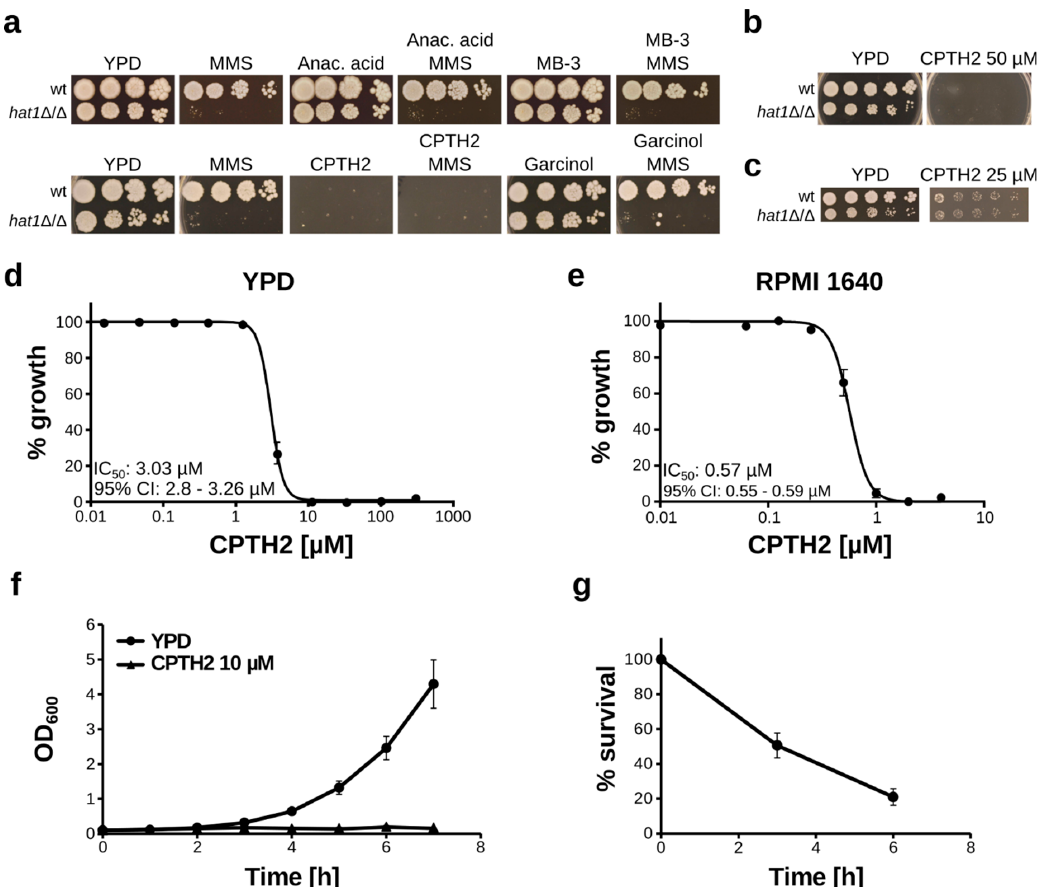
Figure 1. Cyclopentylidene-[4-(4-chlorophenyl)thiazol-2-yl)hydrazone (CPTH2) inhibits C. albicans growth. ( a ) Spot dilution assays of C. albicans wt and hat1 Δ / Δ strains using plates containing the indicated histone acetyltransferase (HAT) inhibitors in the absence or presence of methyl methanesulfonate (MMS). Cells were incubated for 3 days prior to imaging. Concentrations used were 200 µM for CPTH2, anacardic acid, and MB-3, 100 µM for garcinol, and 0.03% for MMS. ( b , c ) Spot dilution assays as described above (a), with 50 µM and 25 µM CPTH2, respectively. ( d ) Liquid growth inhibition assay in YPD medium. C. albicans wt cells were incubated with the indicated concentrations of CPTH2 for 24 h prior to OD 600 measurement. ( e ) Liquid growth inhibition assay as described above (d), using RPMI 1640 medium. Cells were incubated for 24 h prior to OD 600 measurement. ( f ) Growth curves of C. albicans wt cultures in the absence or presence of CPTH2. ( g ) Survival of cells upon CPTH2 treatment. Cells were grown in YPD medium and treated with 10 µM CPTH2 for the indicated time. CFUs were determined by plating and colony counting. (d–g) Data shown are mean +/- sd of three (e–g) or four (d) biological replicates.